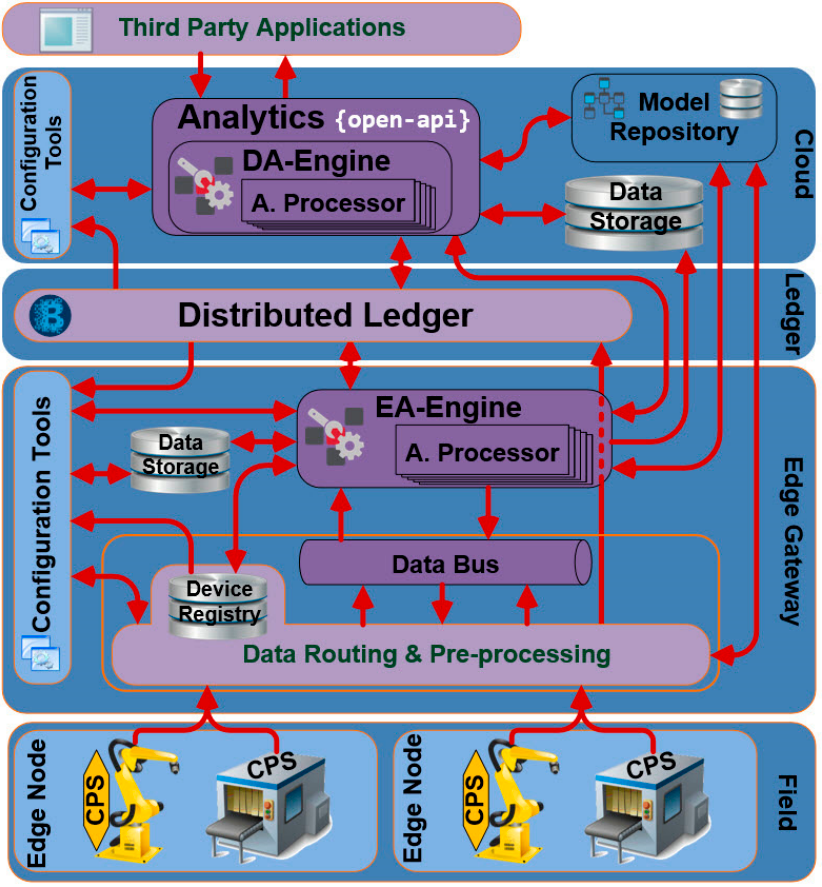
Figure 1. Anatomy of the Distributed Data Analytics Engine (see [16]).